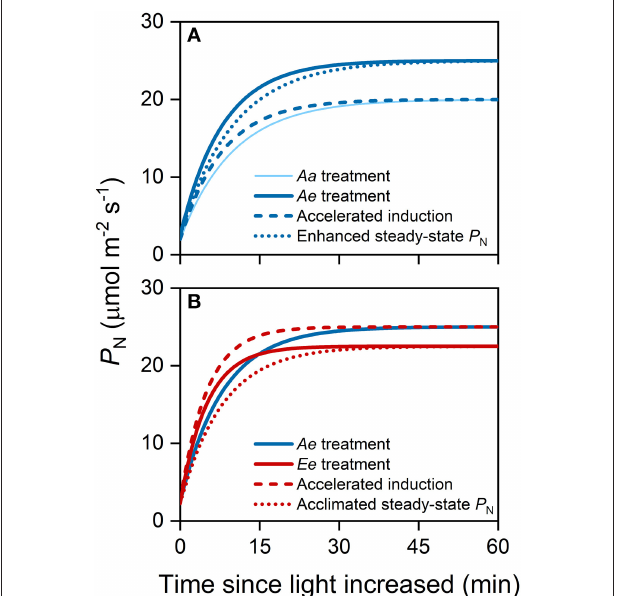
FIGURE 1 | An example illustrating the substrate effect of elevated carbon dioxide (eCO 2 ) (A) and the acclimation effect of eCO 2 (B) on accumulative carbon gain (ACG) via changes in steady-state photosynthetic rates ( P N ) and photosynthetic induction. In this study, we assume that the acclimation to long-term eCO 2 accelerates photosynthetic induction but decreases the steady-state P N at high light intensity. All lines were modeled with an exponential function. (A) The thin solid curve represents the time course of P N following an increase in light intensity from 100 to 1,500 µ mol photons m − 2 s − 1 under the Aa treatment, while the thick solid curve represents that under Ae treatment. The dashed blue curve represents the time course of P N considering accelerated photosynthetic induction only, i.e., the rate of photosynthetic induction is the same as that under the Ae treatment. The dotted blue curve represents the time course of P N considering changes in steady-state P N only i.e., steady-state P N are the same as that under the Ae treatment. (B) The solid red curve represents the time course of P N under the Ee treatment. The dashed red curve represents the time course of P N considering changes in photosynthetic induction only, i.e., the rate of photosynthetic induction is the same as that under the Ee treatment. The dotted red curve represents the time course of P N considering changes in steady-state P N only i.e., the final, steady-state P N is the same as that under the Ee